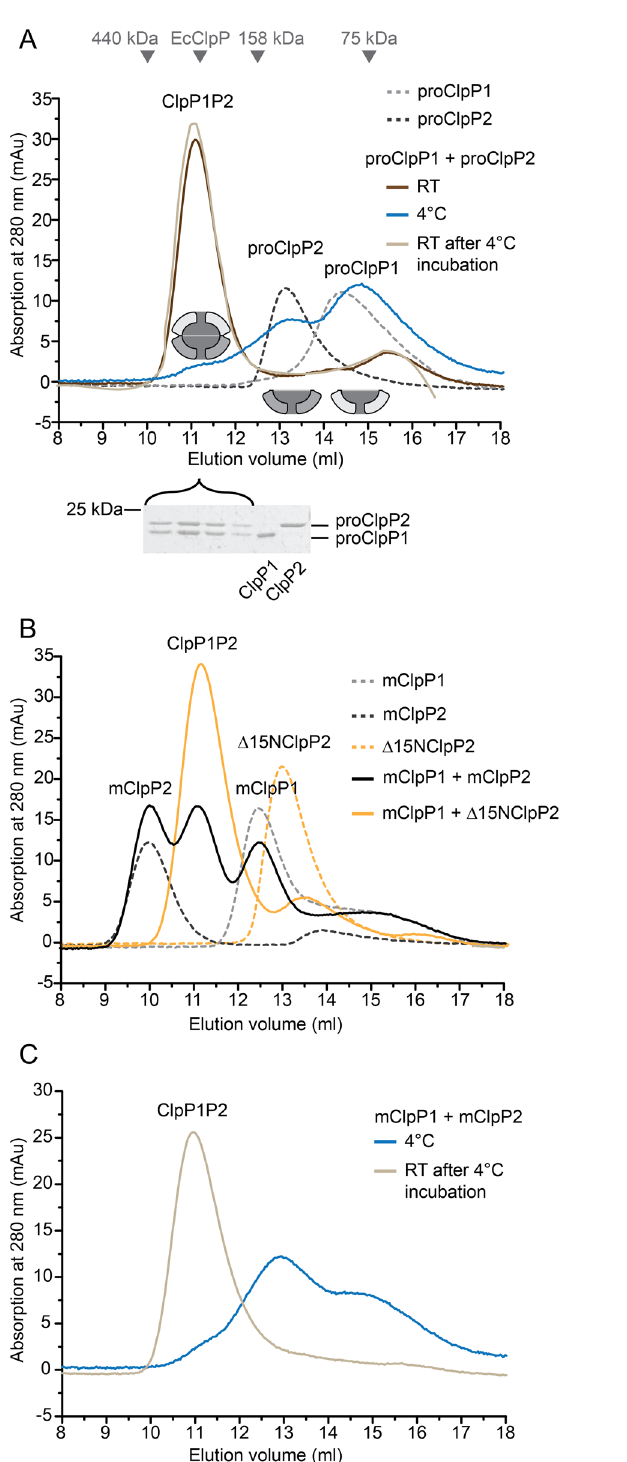
Fig 1. Assembly of ClpP1 and ClpP2 to the ClpP1P2 double-ring particle. Analytical gel filtration runs were performed on a Superdex 200 gel filtration column (24 ml). Unless noted otherwise, all runs were performed at room temperature. The assembly state of the proteins is indicated by a cartoon depiction in the topmost graph of either single rings in light grey for ClpP1 and dark grey for ClpP2, or the assembled double- ring particle. Molecular size markers are indicated as arrow tips above the elution profiles in the first graph.